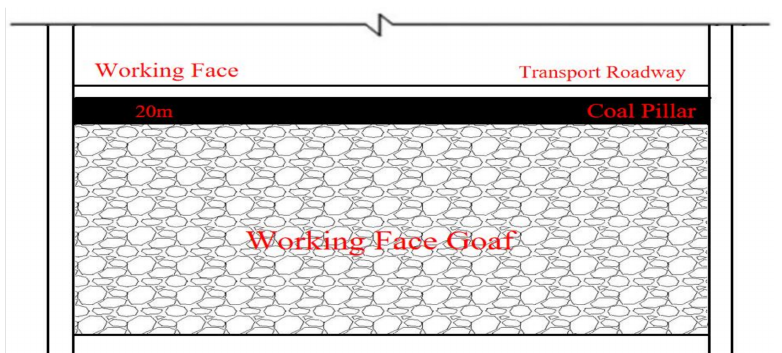
Figure 1. Schematic layout of the working